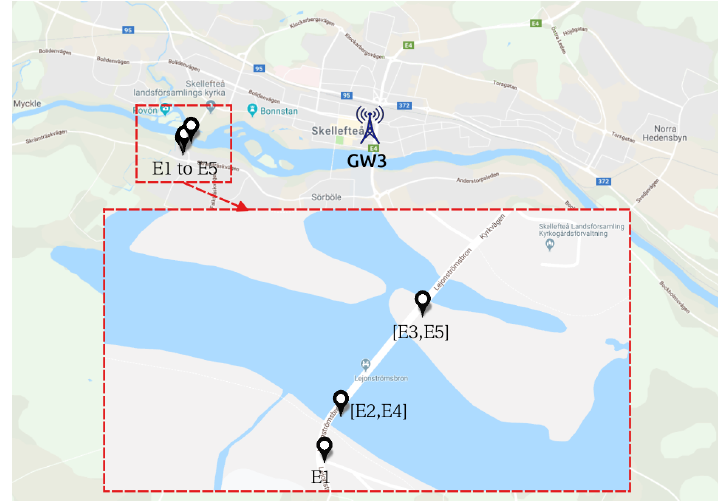
Figure 9. S4—gateway and sensors positioning. Map layer from Google Maps